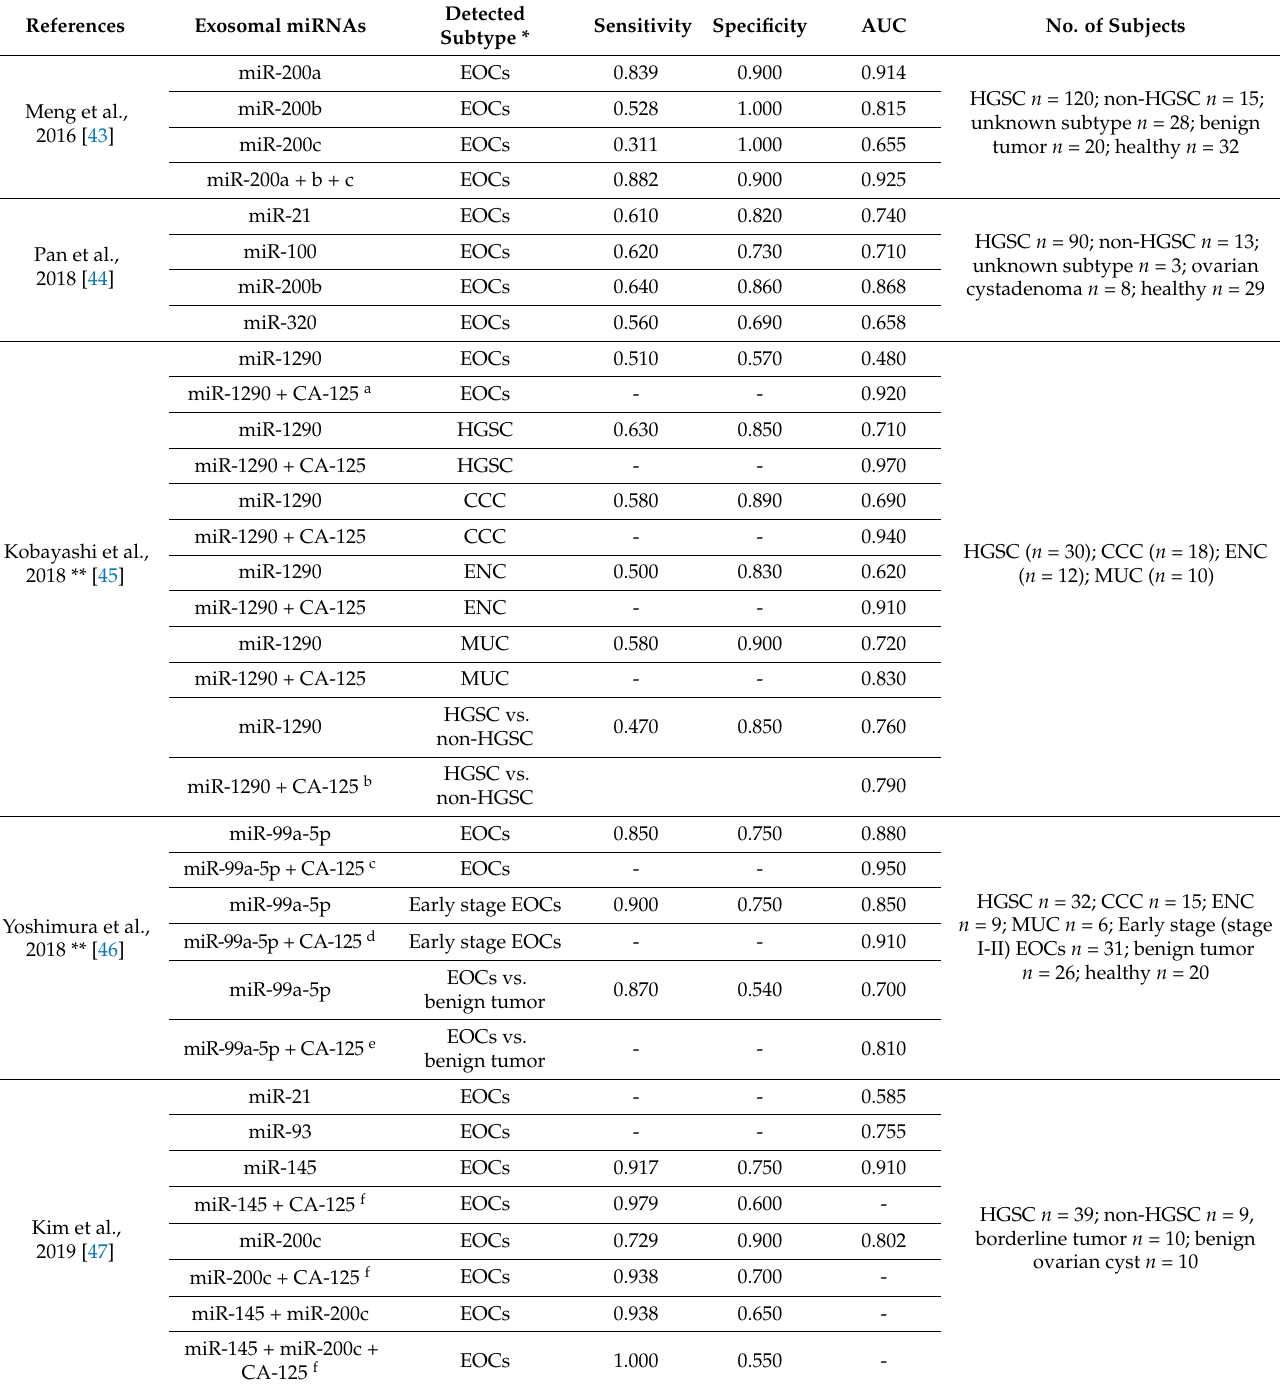
Table 2. Sensitivity, specificity and area under the receiver operating characteristic (ROC) curve (AUC) of the circulating exosomal miRNAs used to detect epithelial ovarian cancers (EOCs) in the literature. HGSC: high-grade serous